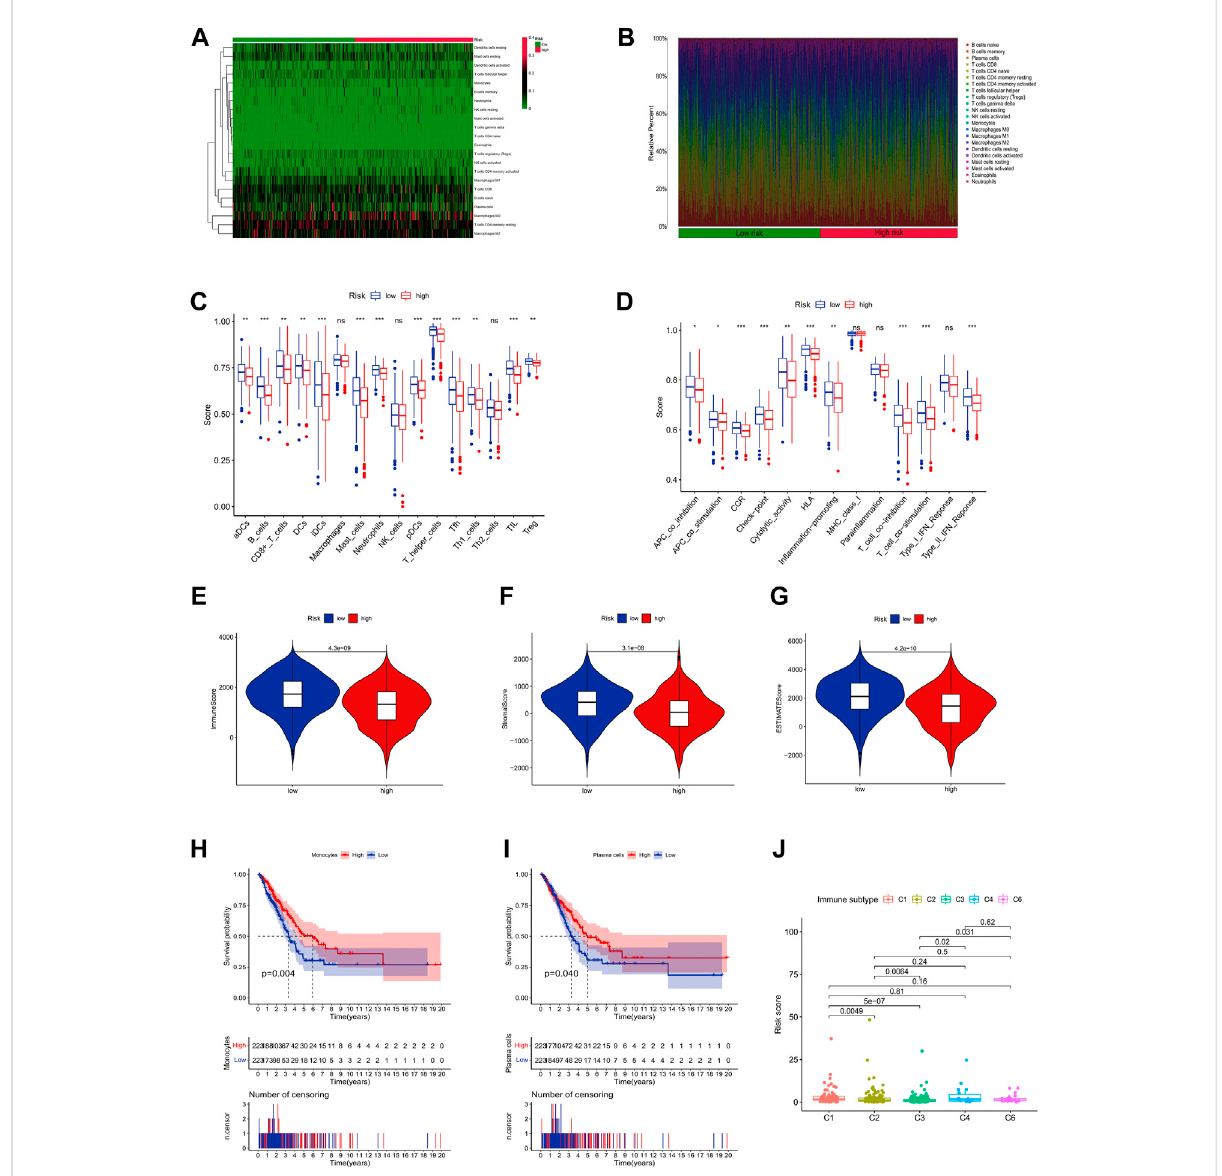
FIGURE 8 Immunein fi ltrationdiscrepancyindifferentriskgroups. (A) Heatmapof22tumor-in fi ltratingimmunecelltypesinlow-riskandhigh-riskgroups. (B) Bar chart of the proportions for 22 immune cell types. (C) The ssGSEA scores of immune functions in low-risk and high-risk groups. (D) Immune cells in low-risk and high-risk groups. (E – G) The TME scores between high-risk and low-risk groups. (H,I) Survival analysis of combined immune cells. (J) Immune